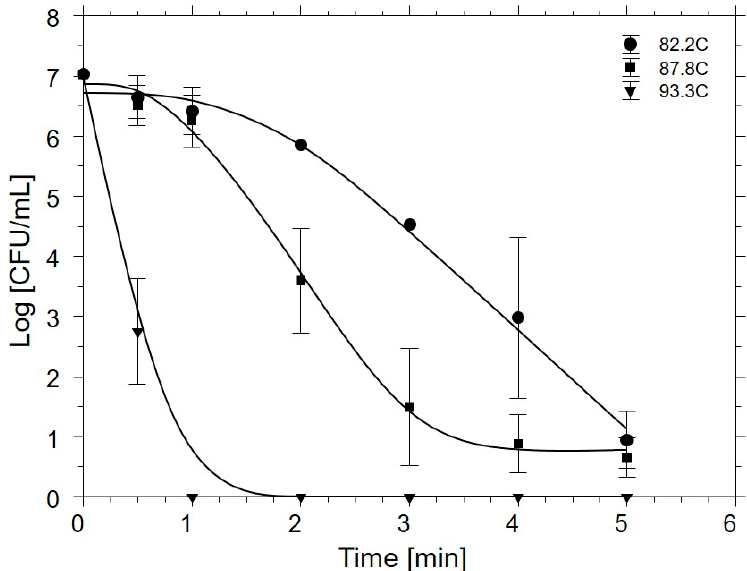
Figure 3. Mean numbers of surviving Salmonella enterica in whole chicken blood subjected to heating at 82.2, 87.8, or 93.3 ◦ C. Values depict means from three identically completed replicates ( N = 3); error bars present one standard error. Salmonella cells were enumerated on bismuth sulfite agar supplemented with 0.1% ( w / v ) sodium pyruvate, after plates were incubated at 36 ± 1 ◦ C for 24–48 h.